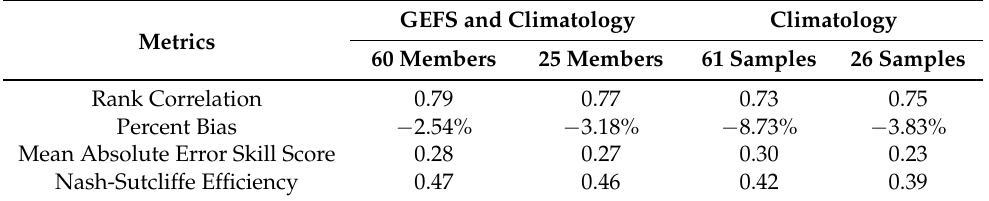
Table 2. Median metrics for daily median forecasts (1 October–31 July) of different scenarios for